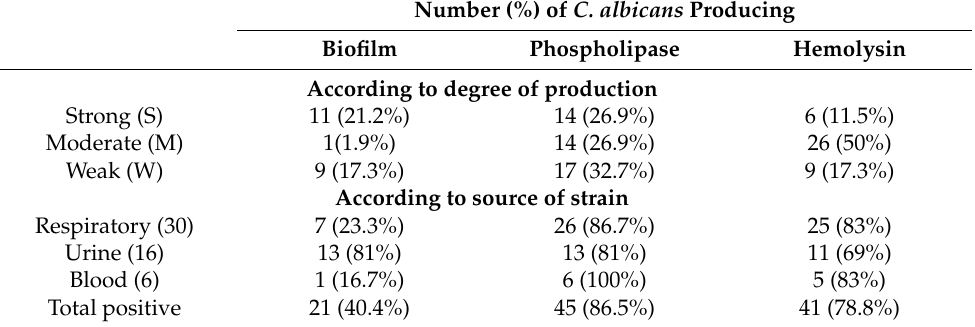
Table 2. Number and percentage of C. albicans isolates from different clinical sources producing biofilm, phospholipase and